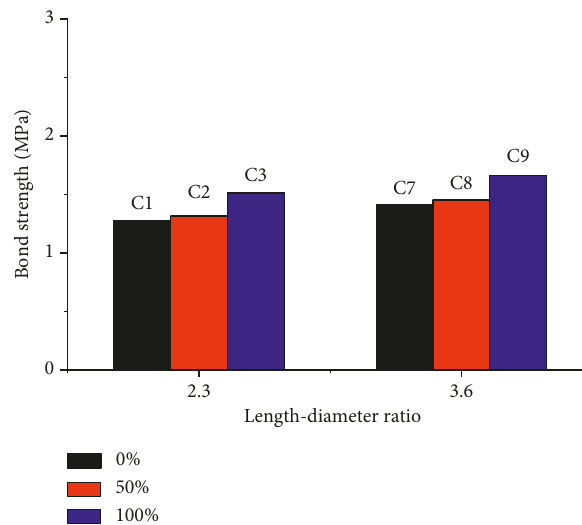
Figure 12: Effect of length-diameter ratio on bond